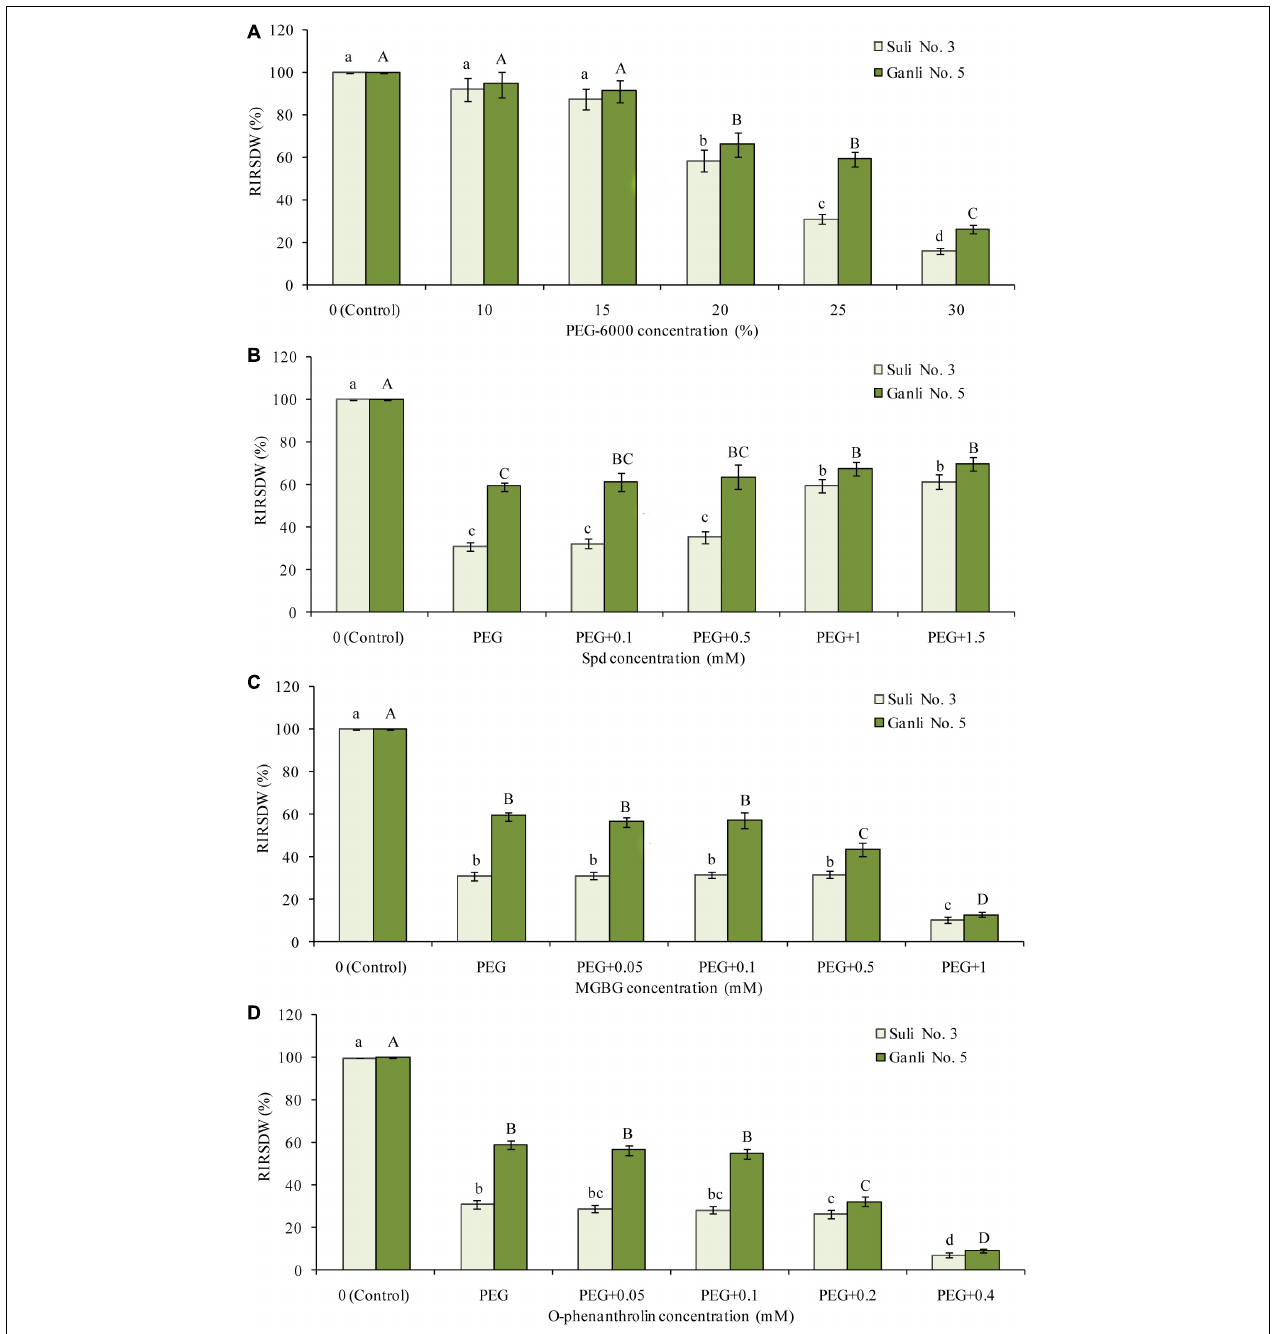
FIGURE 1 | Effects of PEG (A) , PEG + Spd (B) , PEG + MGBG (C) , and PEG + o-phenanthroline (D) at the different concentrations on RIRSDW. The roots of plum seedlings were grown in Hoagland solutions with PEG-6000, Spd, MGBG, or o-phenanthroline at different concentrations. The data here were means ( n = 9) ± standard error of 3 independent experiments. Significant differences between treatments are indicated with letters, with upper and lower letters for each cultivar ( P <